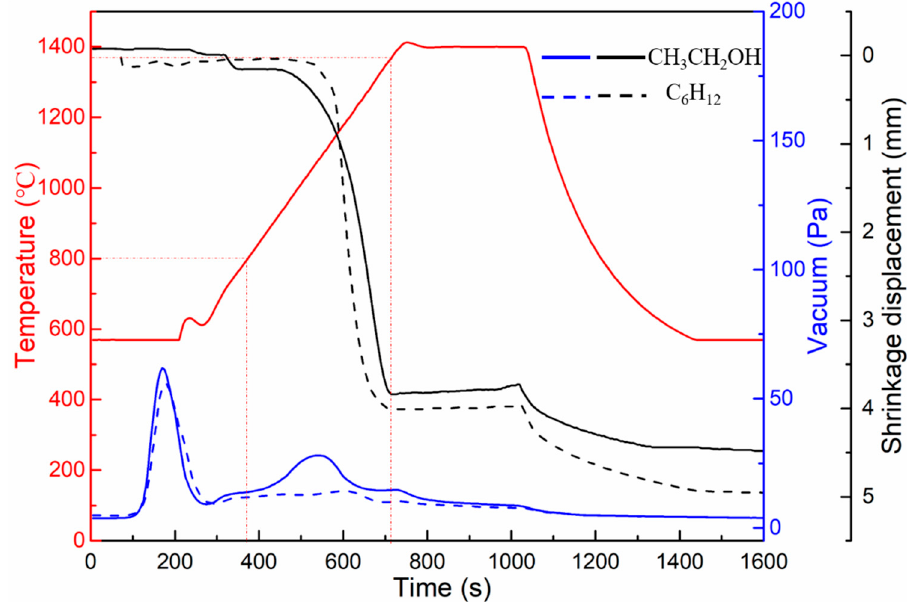
Figure 5. Densification curves for specimens sintered at 1400 °C using different ball-milling suspensions.